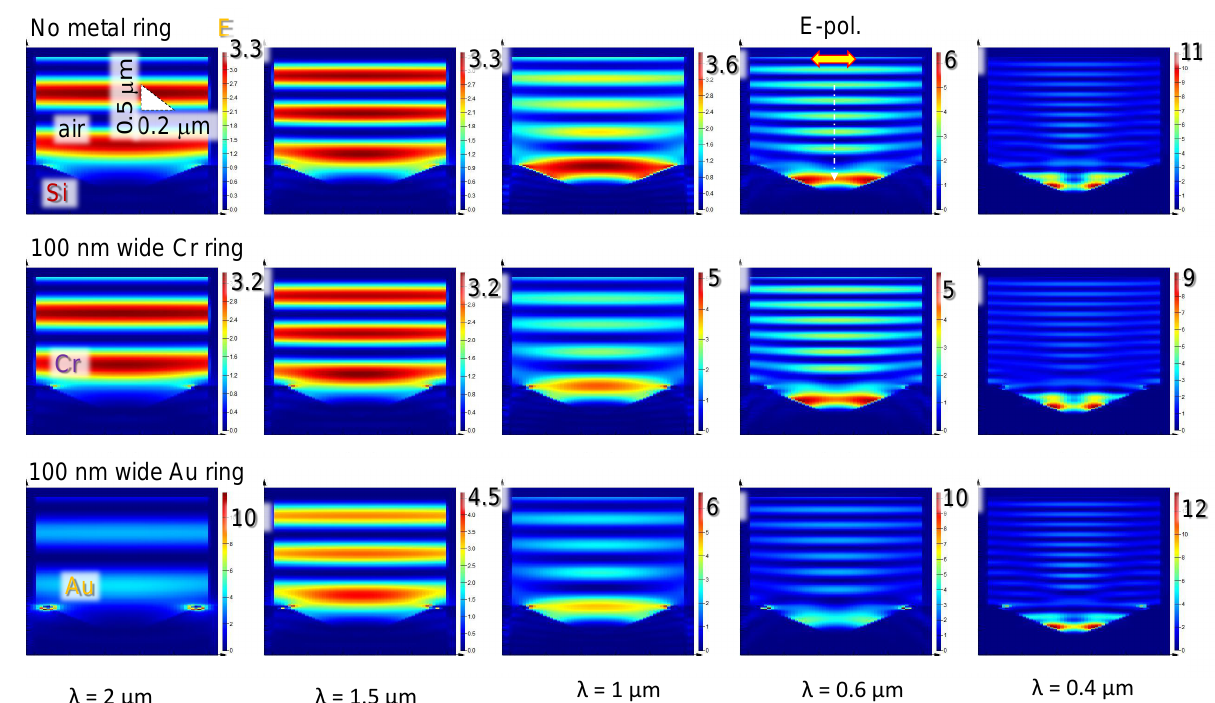
Figure 8. FDTD simulations (Lumerical ANSYS). Reflection from a structure of 100-nm-wide (30-nm- thick) Cr or Au ring of 900 nm diameter on an etched inverted pyramid on Si (cid:104) 001 (cid:105) plane at different wavelengths; top-row is reference with no metal ring. Color map shows light enhancement; incident light is E = 1. Calculations were carried out with periodic boundary conditions (in surface plane of Si wafer). Material properties are taken from Lumerical database. Note the different dimensions in horizontal and vertical